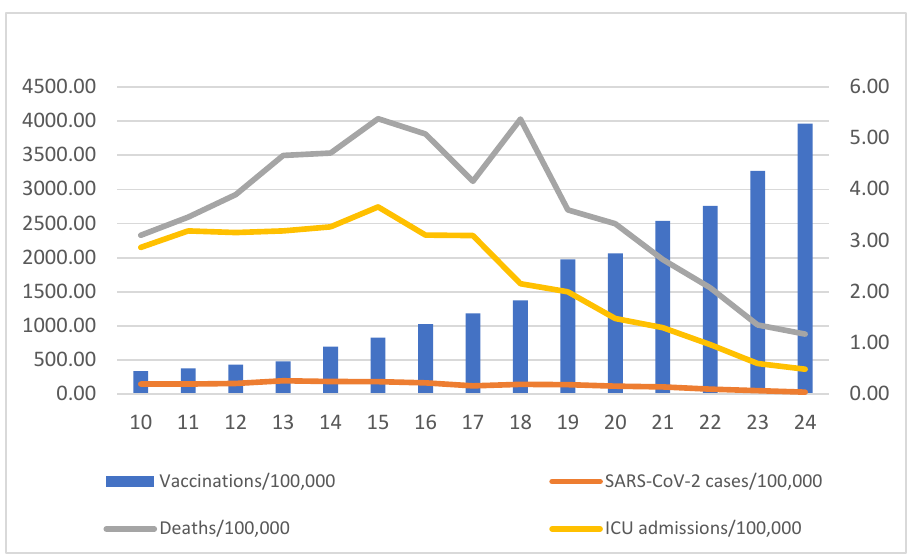
Figure 3. The course of vaccinations (per 100,000 population) in relation to weekly average of SARS-CoV-2 cases, COVID-19-related ICU admissions and COVID-19 deaths.